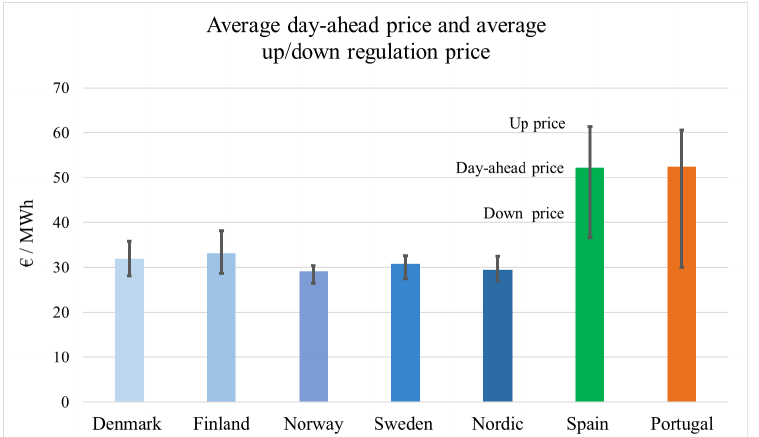
Figure 2. Average spot price and average up/down regulation price for 2017 (original